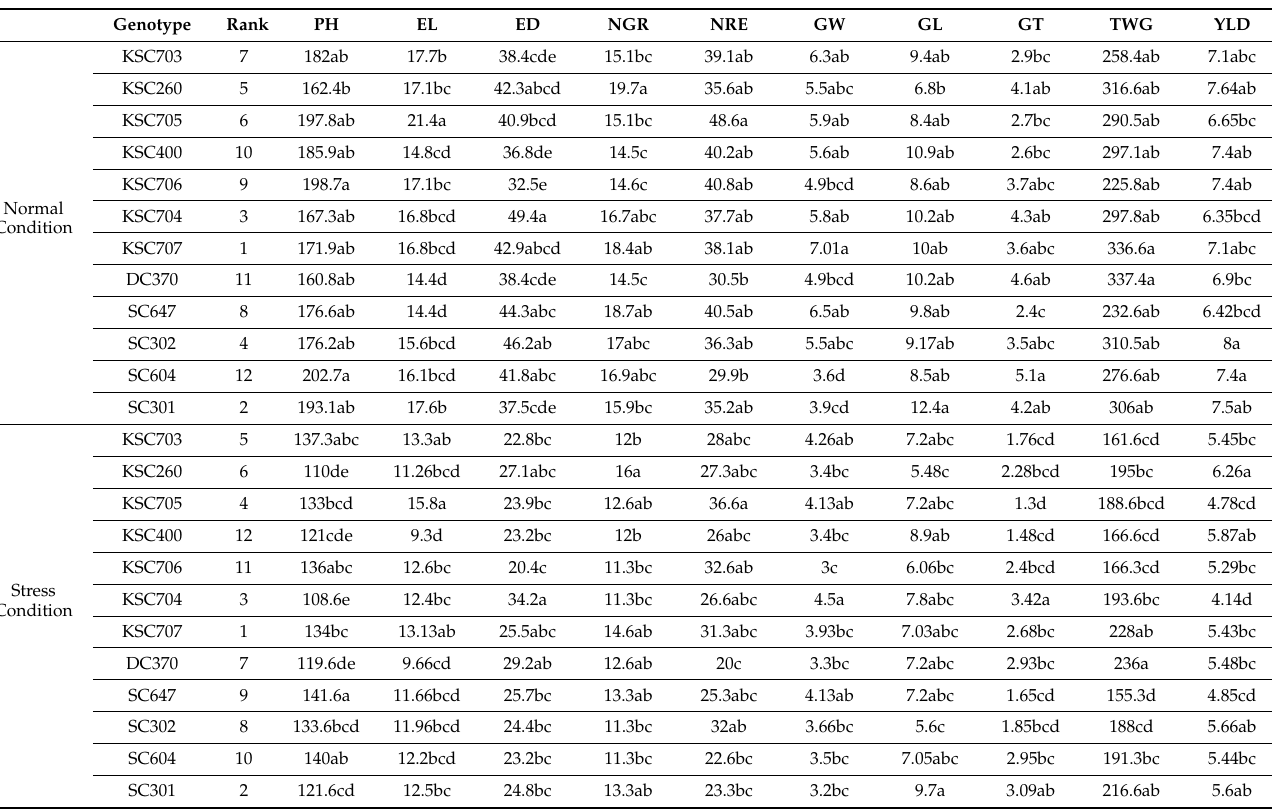
Table 2. Comparison of Duncan’s mean for traits in 12 hybrids of maize under normal conditions and humidity